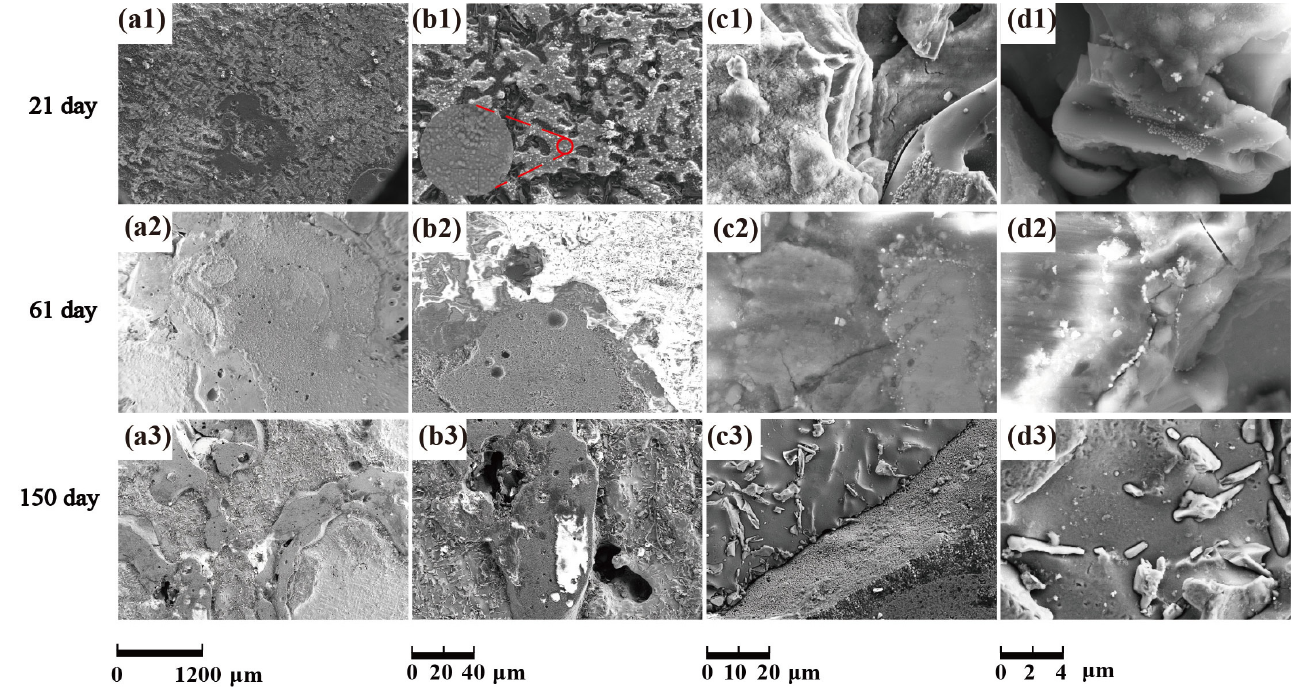
Figure 12. Morphology of corrosion products of SiC 3D /6061Al for different SL times. ( a1 – a3 ) Corrosion morphology of SiC 3D /6061Al with low magnification; ( b1 – b3 ) Corrosion morphology of the interface of SiC 3D /6061Al with low magnification; ( c1 – c3 ) Corrosion morphology of the interface of SiC 3D /6061Al with high magnification; ( d1 – d3 ) Corrosion morphology of the interface of SiC 3D /6061Al with the highest magnification.